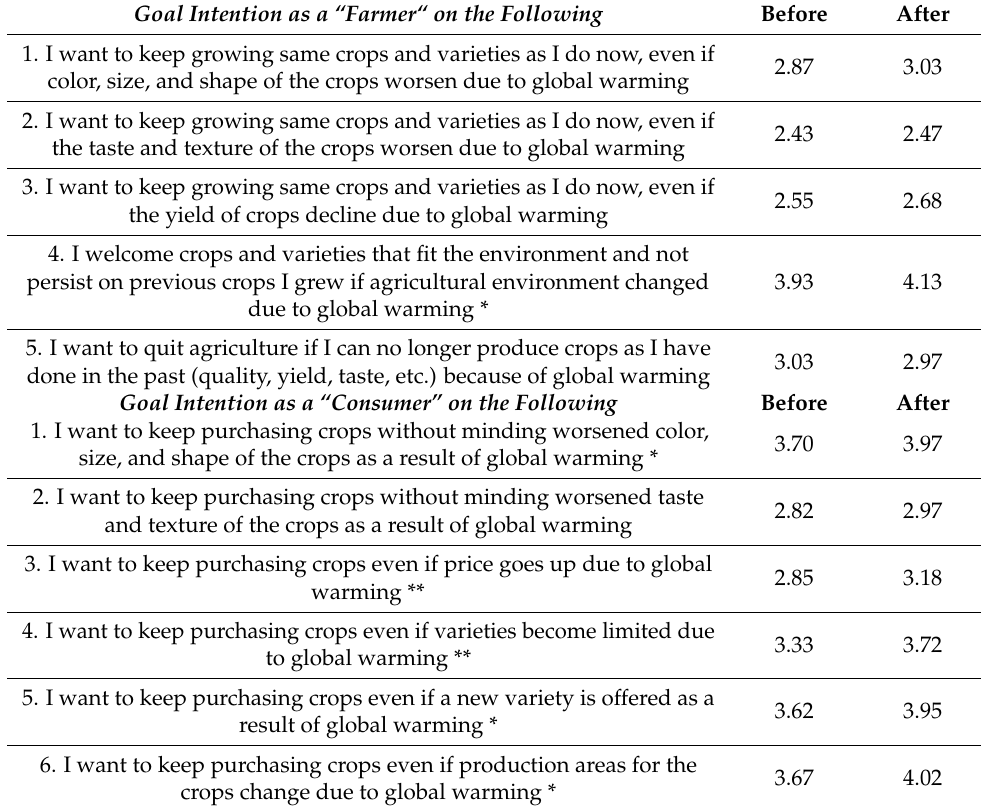
Table 7. Goal intention of the climate change impacts and damages in the agriculture and rural areas. Goal Intention as a “Farmer“ on the Following Before